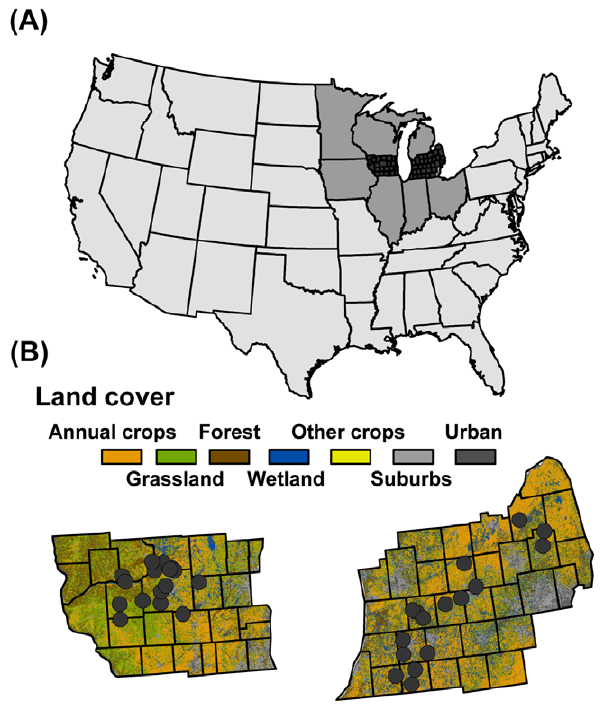
Figure 1. Study sites. Location of study sites (gray circles, B) in relation to landcover characteristics (B), and location of study region (dark gray polygons, A) in relation to the Midwest (medium gray, A) and the continental United States (light gray,